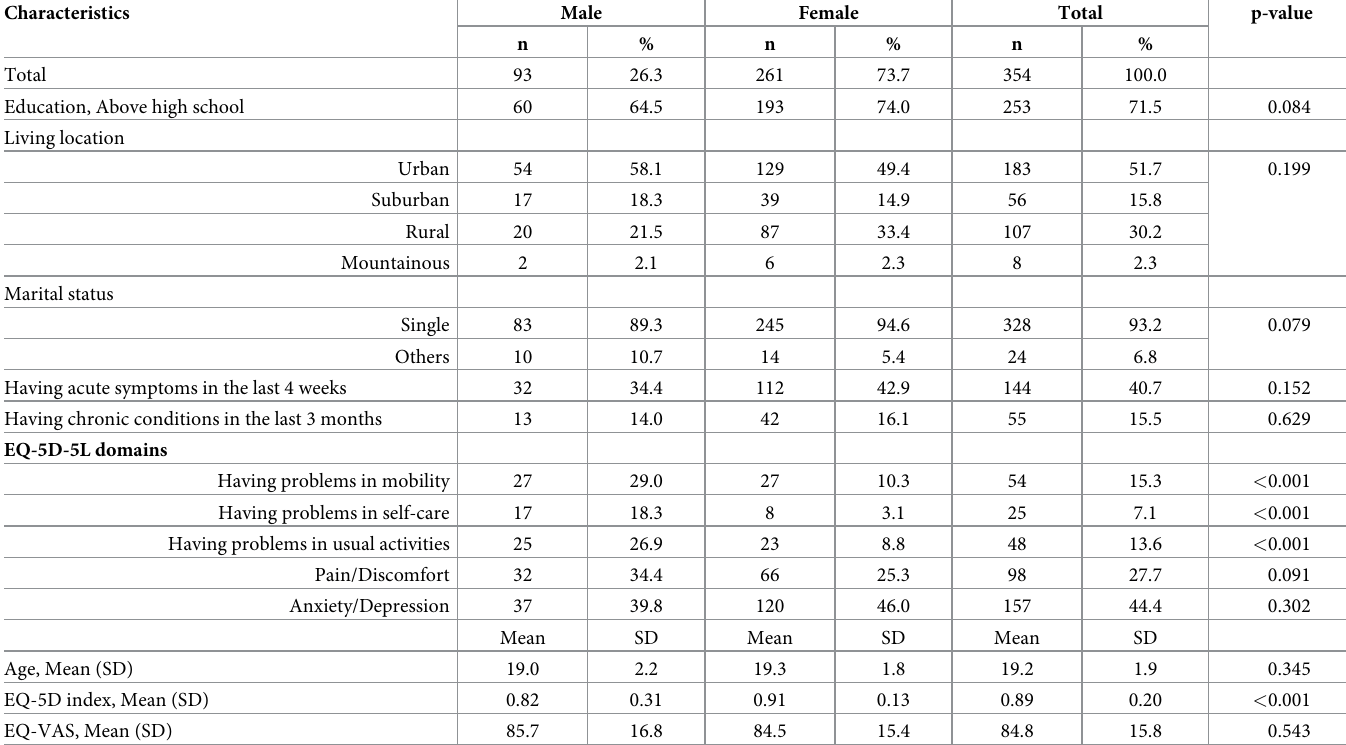
Table 1. Socio-demographic and health status characteristics of respondents.